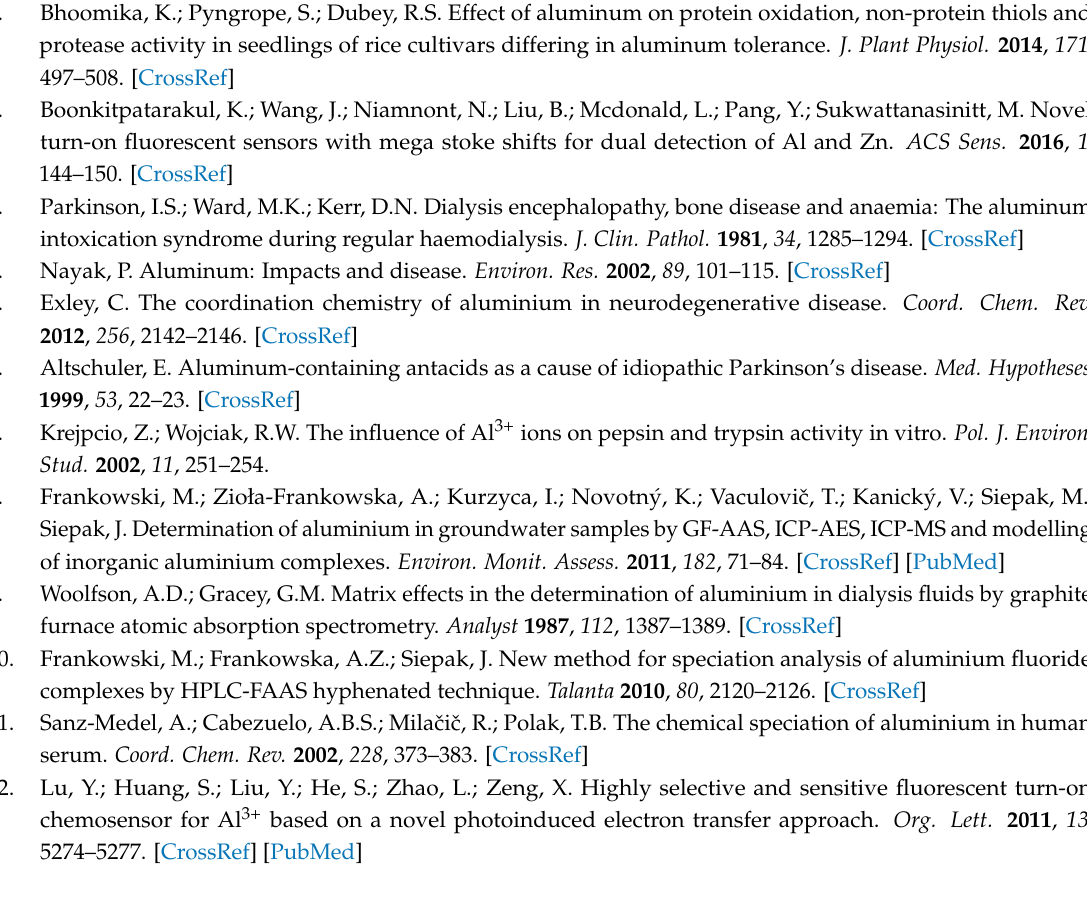
Figure S14: Photographs of test strips after being dipped into Al 3+ solutions with different concentrations under a 365 nm UV lamp (from left to right: 10 − 6 M, 10 − 5 M, 10 − 4 M, 10 − 3 M, 10 − 2 M); Figure S15: Photographs of test strips after being dipped into aqueous solutions of Al 3+ (100 µ M) mixed with different metal ions (100 µ M) under a 365 nm UV lamp (from left to right, up: Al 3+ , Ba 2+ , Ce 3+ , Cd 2+ , Co 2+ , Cr 3+ , Cu 2+ and Fe 3+ ; down: Hg 2+ , In 3+ , K + , Mn 2+ , Na + , Ni 2+ , Pb 2+ and Zn 2+ ); Figure S16: Fluorescence spectra of PEGBAB (10 µ M) in different aqueous solution; Figure S17: Photographs of test strips after being dipped into Al 3+ solutions (100 µ M) at different temperature under a 365 nm UV lamp (from left to right: 20 ◦ C, 30 ◦ C, 40 ◦ C, 50 ◦ C, 60 ◦ C, 70 ◦ C, 80 ◦ C); Figure S18: Photographs of test strips after being dipped into Al 3+ solutions (100 µ M) under a 365 nm UV lamp: (a) stored in air for 1 day; (b) stored in air for 7